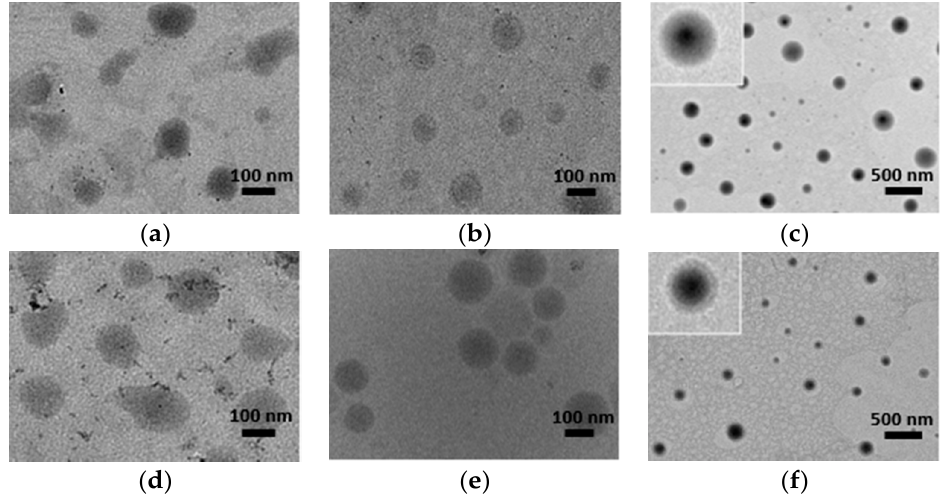
Figure 4. TEM images of the two polymers. The upper images show ( a ) CA-CP blank micelles at pH 7.4, ( b ) pH 5.0, and ( c ) PTX-loaded micelles. The lower images show ( d ) CA-CDEP blank micelles at pH 7.4, ( e ) pH 5.0, and ( f ) PTX-loaded micelles. The concentration of all samples is 0.5 mg/mL.